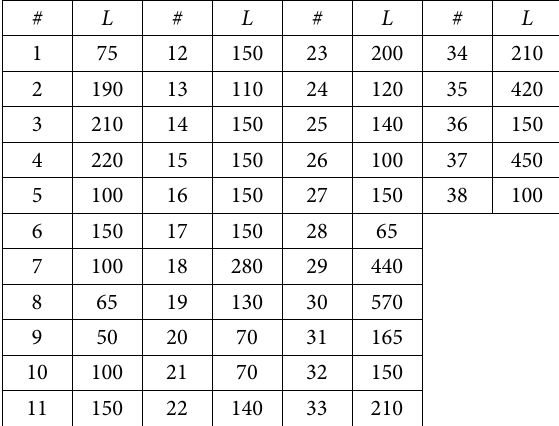
Table A2. Section information (i.e.